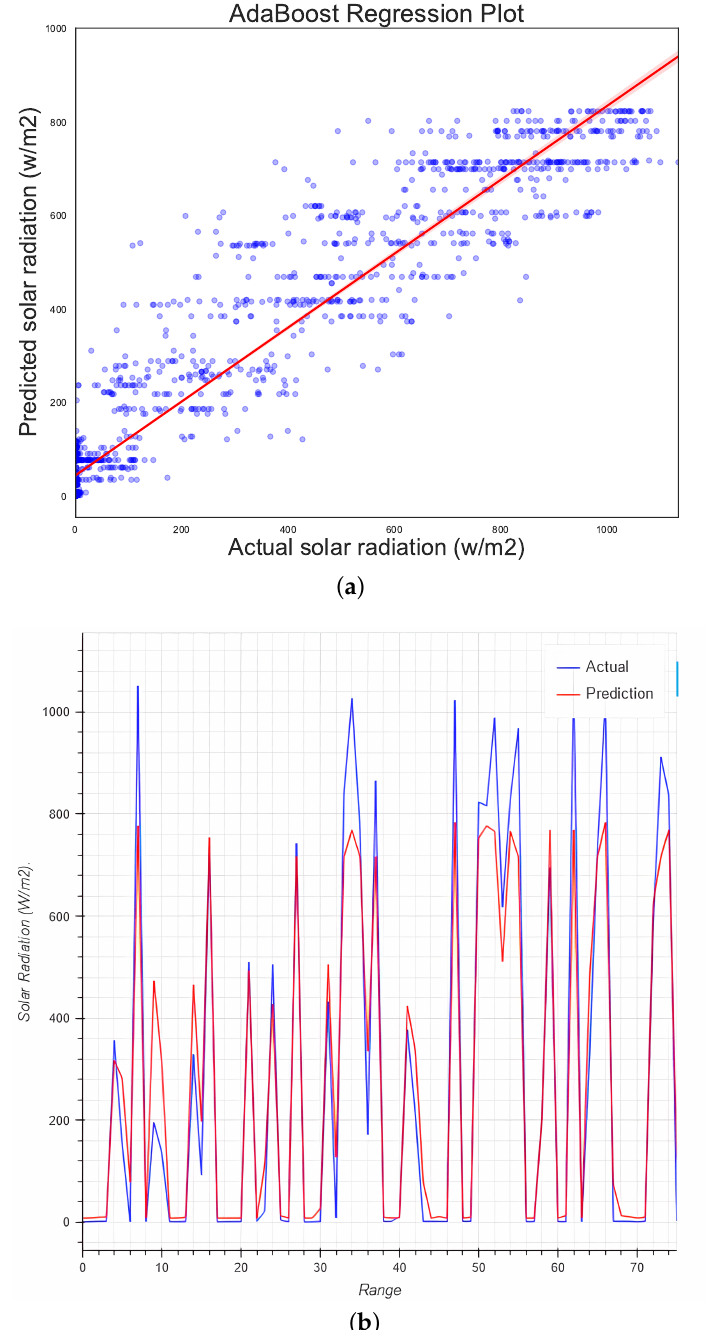
Figure 12. Regression plots for ( a ) Adaboost regression library and ( b ) the predicted results vs. the real